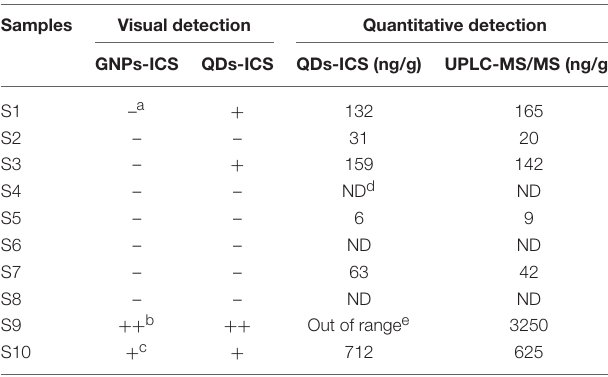
TABLE 4 | The screening of blind tea samples by GNPs-ICS, QDs-ICS, and UPLS-MS/MS.